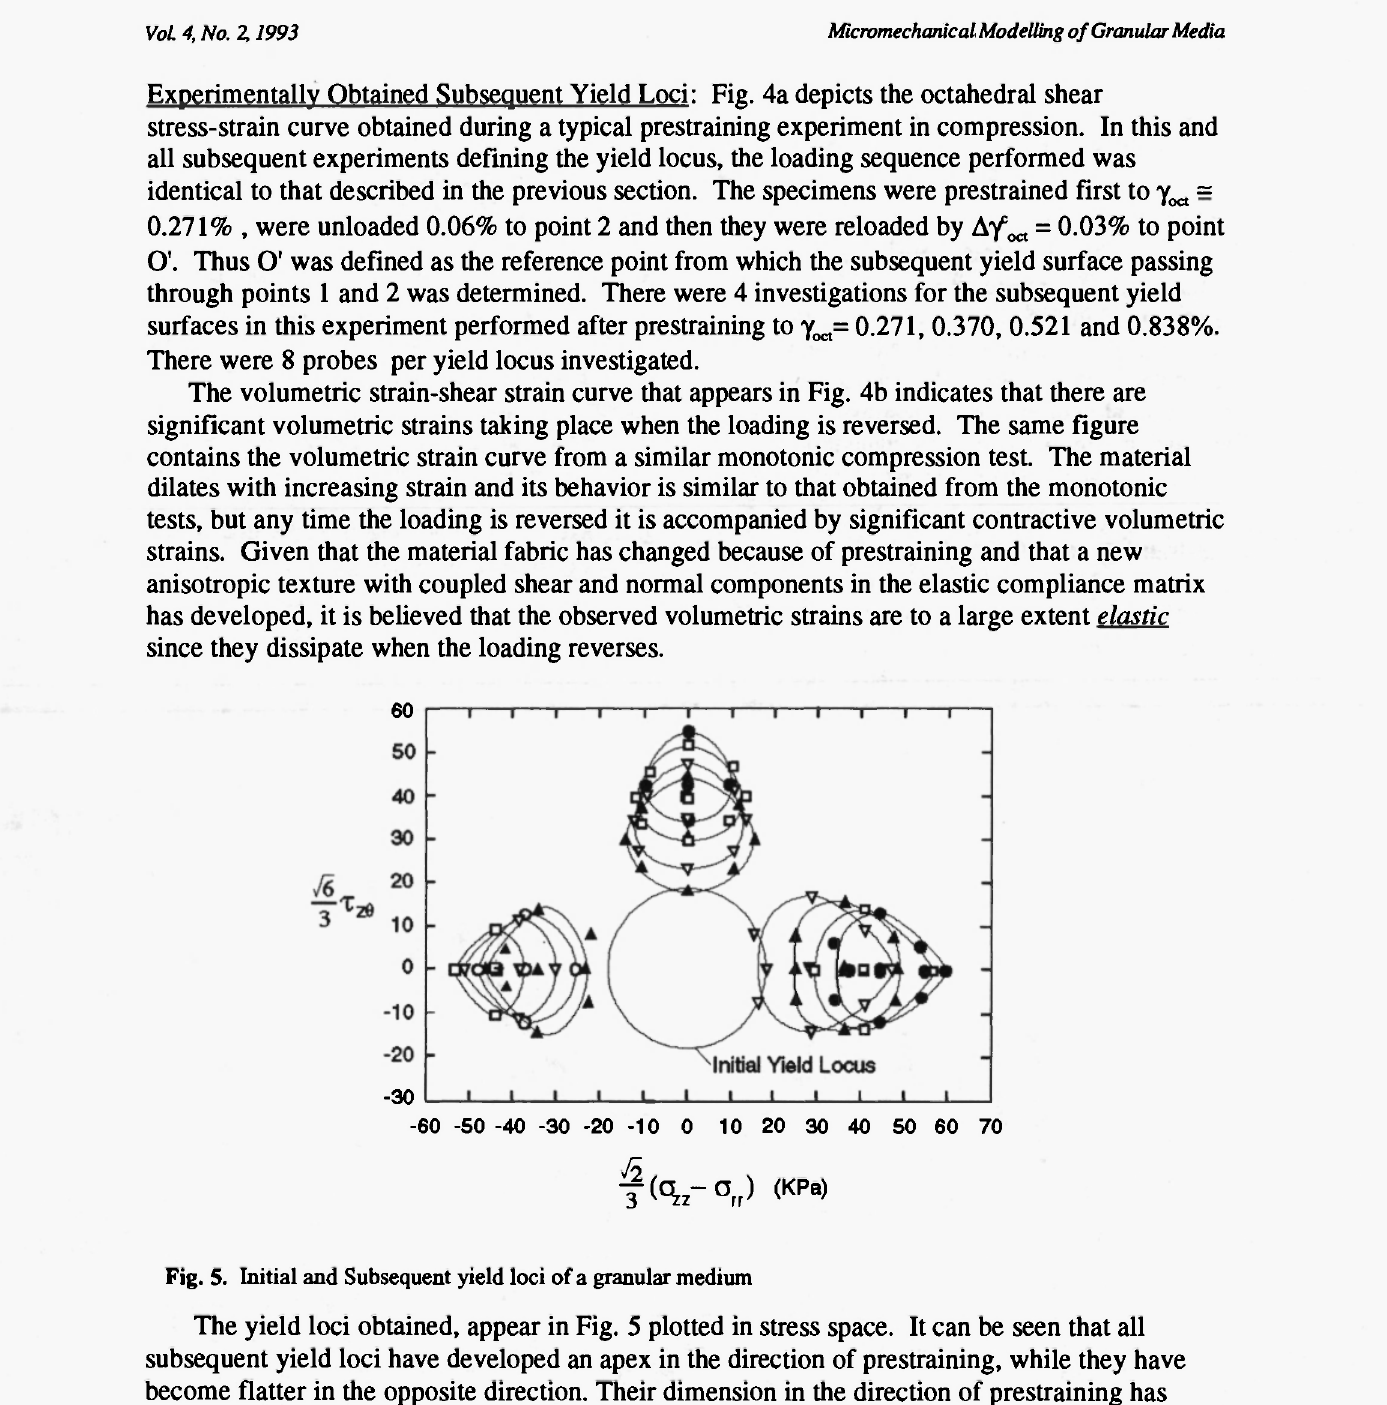
Fig. 5. Initial and Subsequent yield loci of a granular